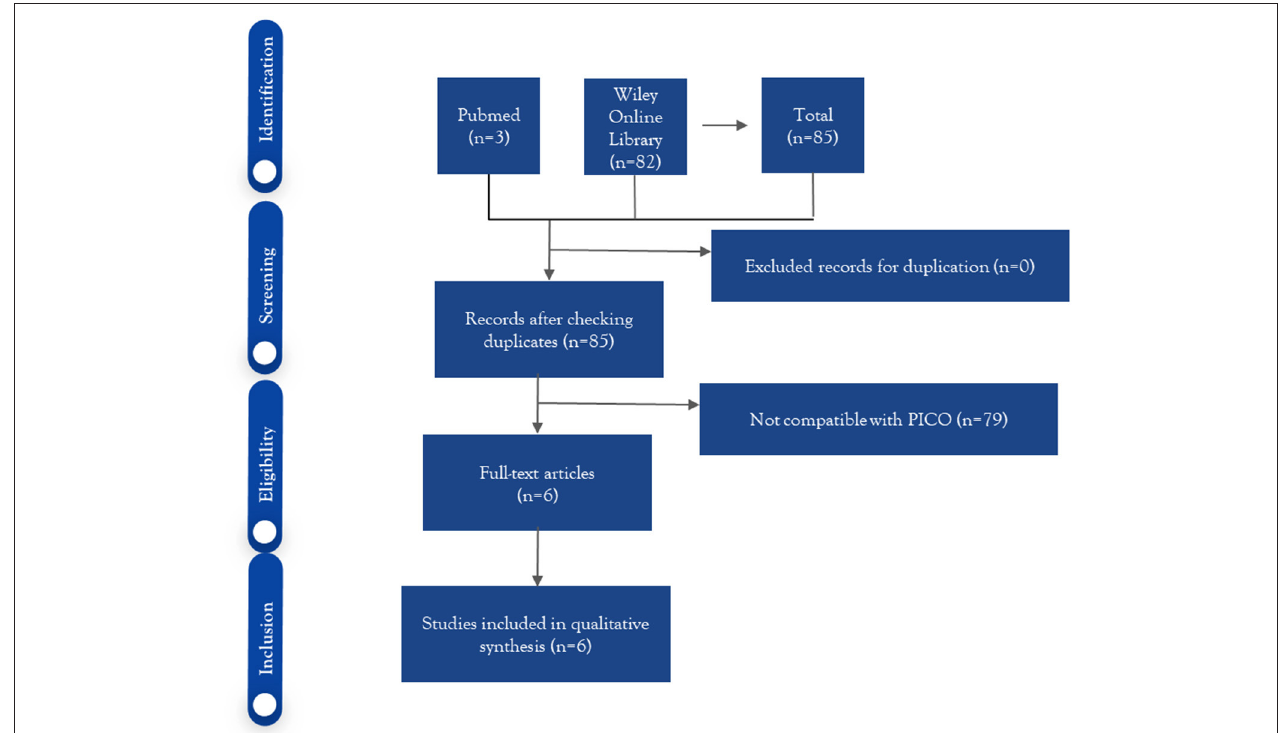
FIGURE 1 | PRISMA protocol